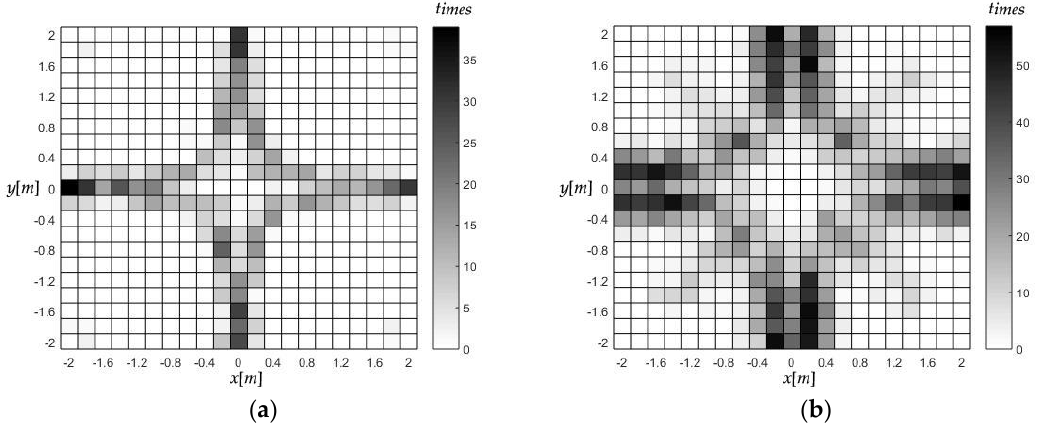
Figure 9. The divergence times distribution of Taylor and Jεa -based-FoPC. ( a ) σ = 0.03 m, ( b ) σ = 0.1 m.